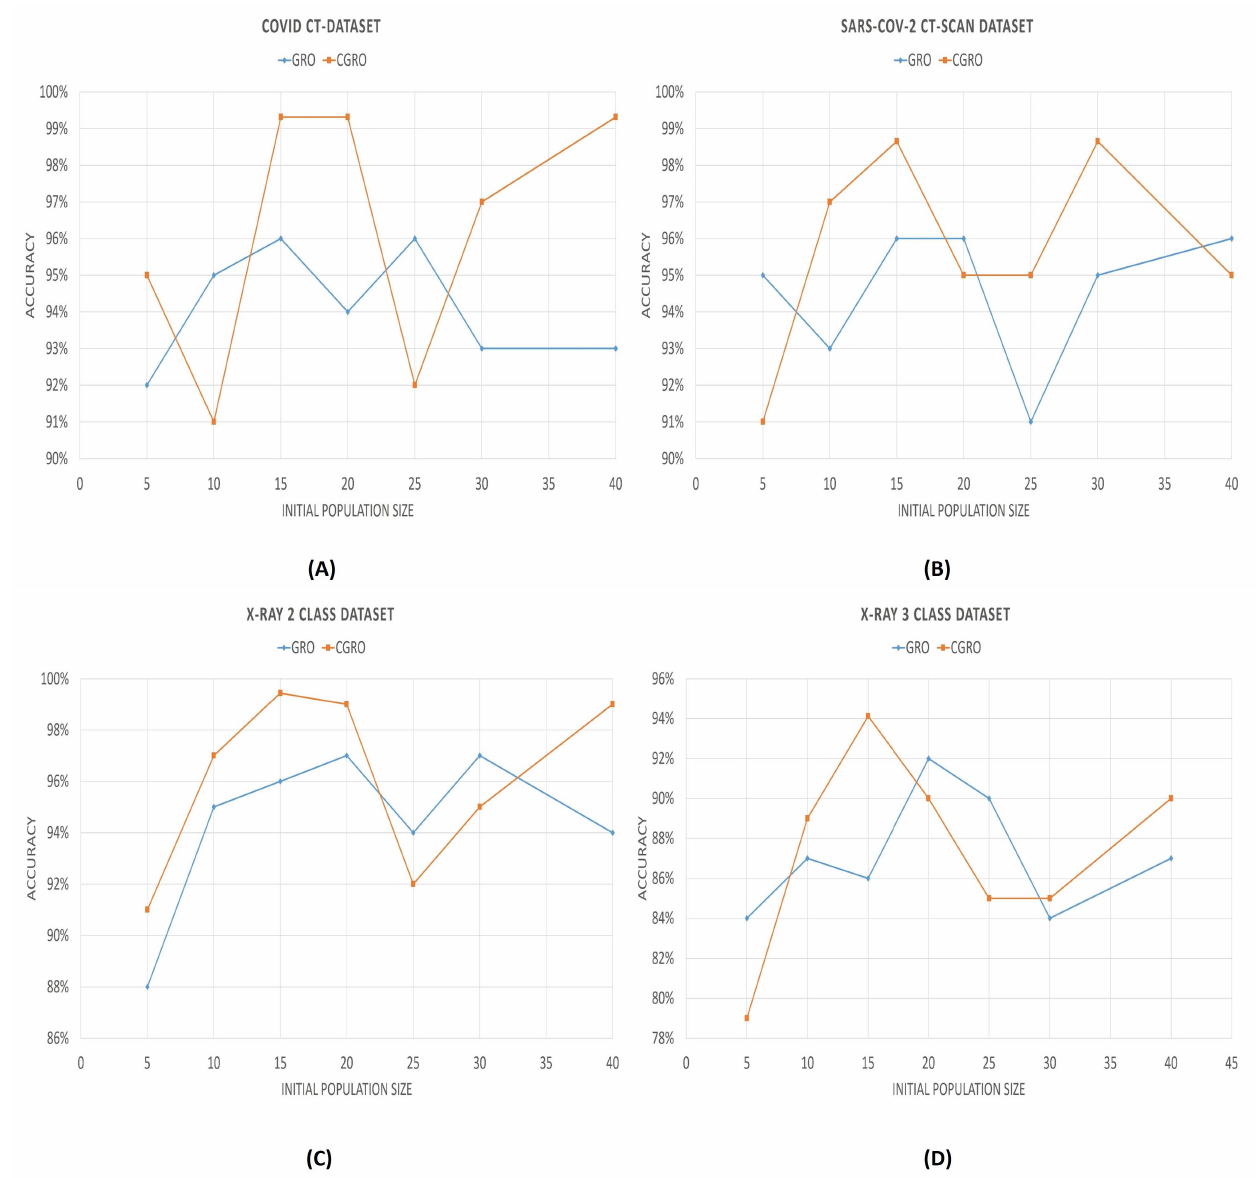
Figure 10. Graph showing the variation of classification accuracies with respect to the initial population size. In the Figure ( A – D ) denote the variations of COVID CT-Dataset, SARS-COV-2 CT-SCAN Dataset, 2 class and 3 class X-Ray